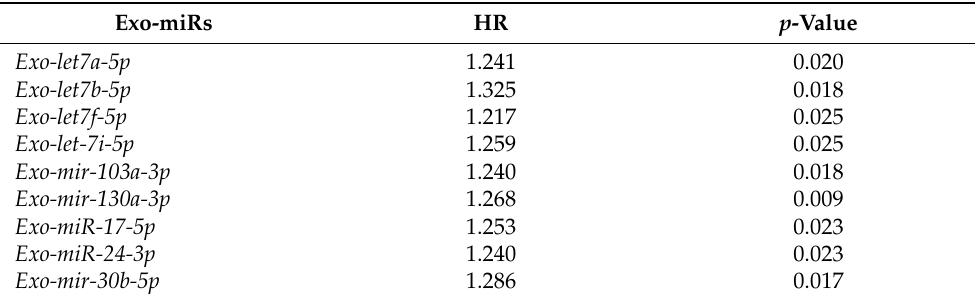
Table 2. Coefficients and relative p -value of the univariate Cox regression models using 9 Exo-miRs, obtained by microarray (n = 67).